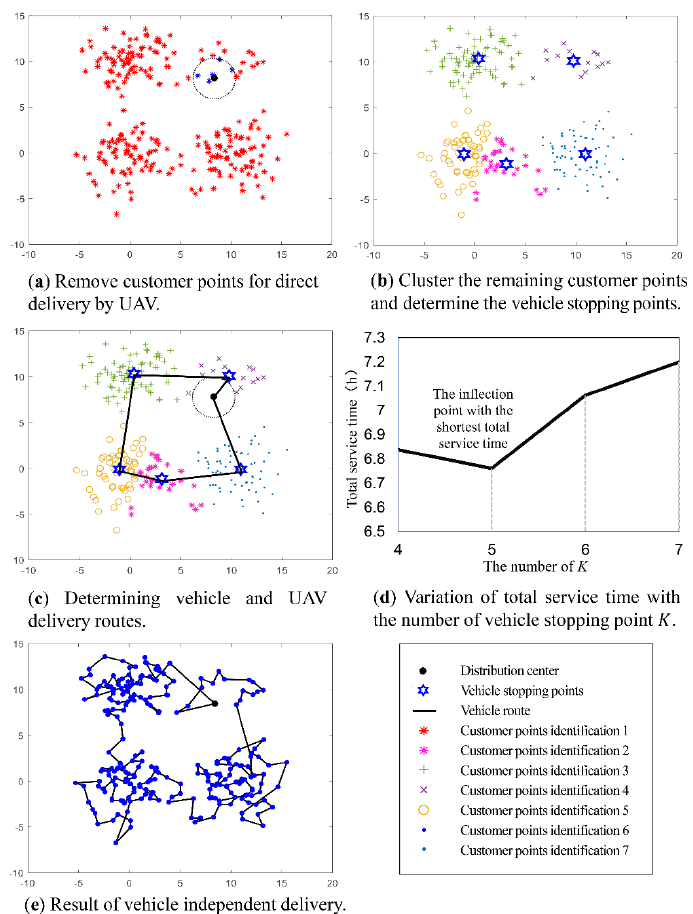
Figure 6. Illustration of the example of C1.